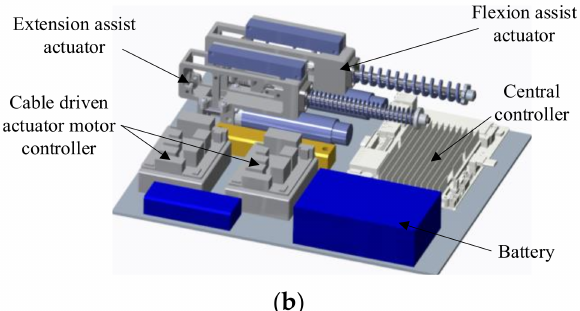
Figure 1. Schematic diagram of cable driven flexible exoskeleton. ( a ) Overall structure diagram. ( b ) Schematic diagram of actuating control box.